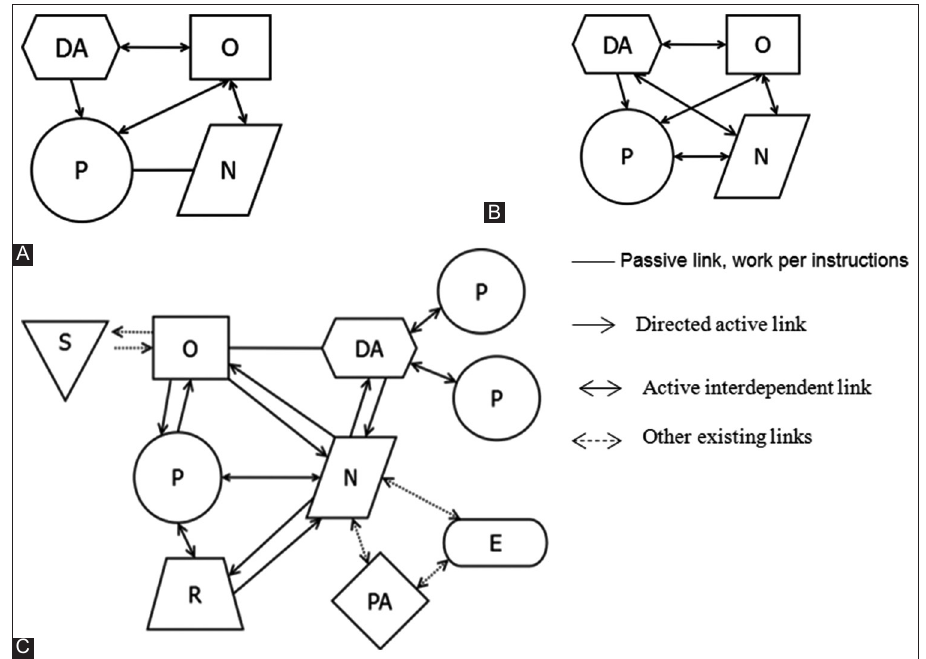
FIGURE 1. (A) Power diagram with ethical dilemma present; (B) Power diagram at status quo ; (C) Power diagram of desired state. P – patient, N – nurse, O – organization, R – relatives and people close to the patient, DA – other providers, S – state, E –